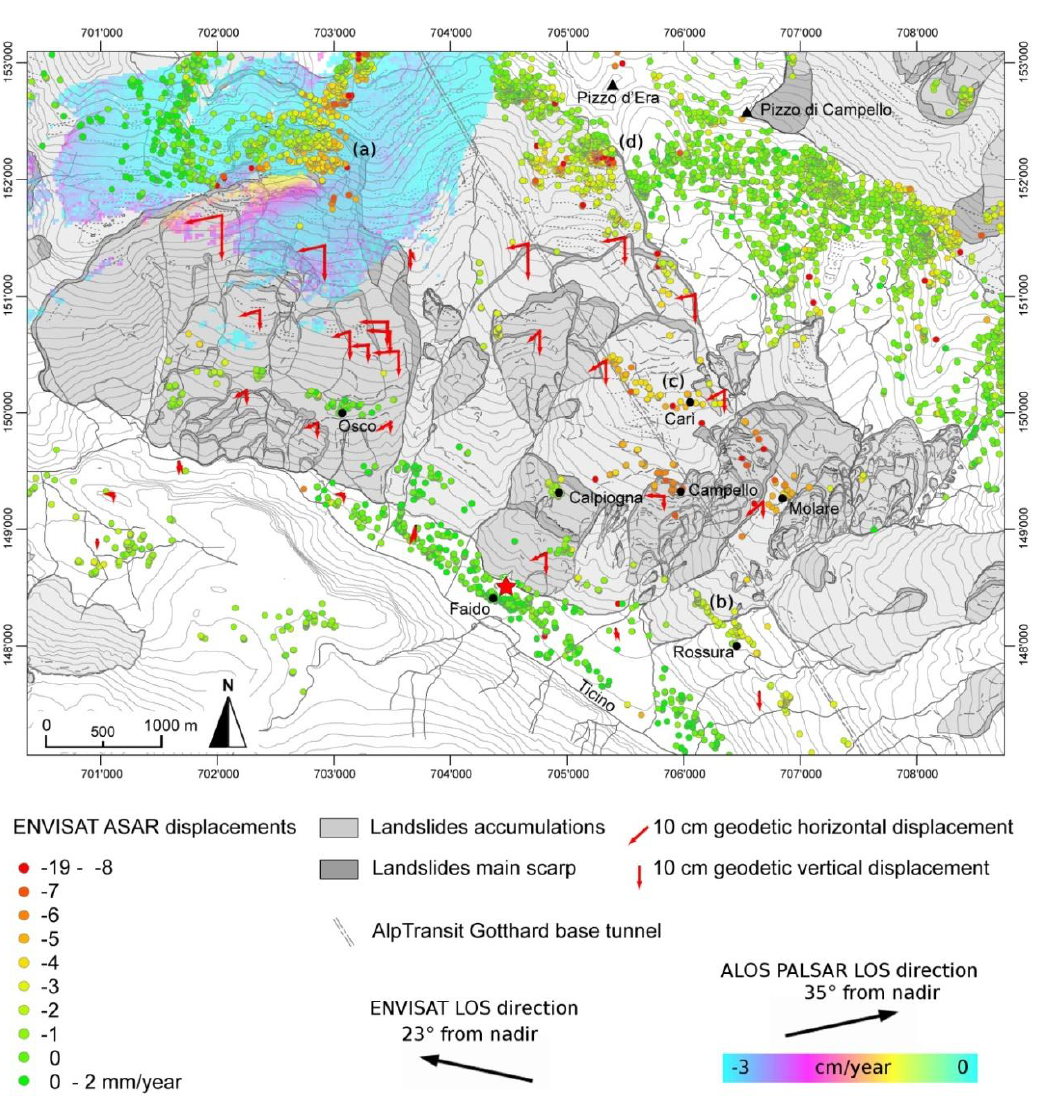
Figure 5. Average displacement rates of point targets in the satellite LOS direction from ENVISAT ASAR data for the time period 2003–2010, plotted on the sketch map with geomorphological features. Negative values indicate an increase in the distance from target to satellite; the red star indicates the location of the reference point. The displacement map from the ALOS PALSAR interferogram 2007.10.28–2010.06.20 is also shown using a different color scale for the western-upper part of the slope. The vectors indicate the horizontal and vertical displacements of some geodetic points determined with GPS between 2003 and 2010. The characters (a), (b), (c) and (d) indicate the geographical locations of the profiles shown in Figure 6. The dotted line shows the Alptransit